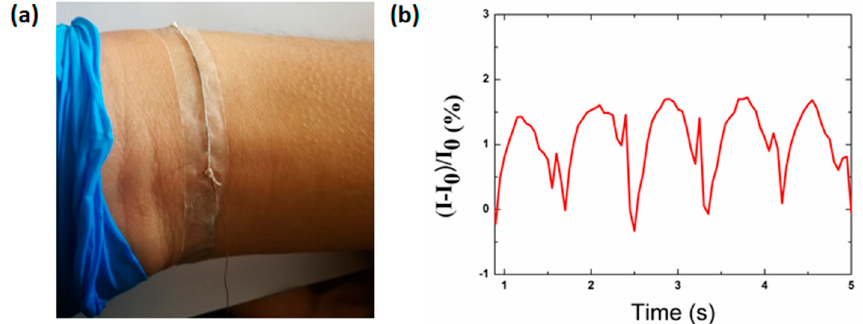
Figure 7. ( a ) Photograph of strain sensor attached on the wrist. ( b ) Relative current response of the strain sensor in monitoring the pulse pressure of a human wrist (physical condition-age: 40 years, height: 170 cm, and weight: 69.5 kg).